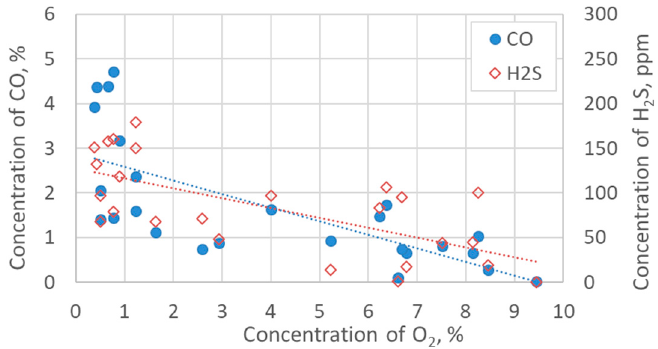
Figure 10. Comparison of average concentration values for six boiler operation variants and average corrosion rate in the tested boiler.